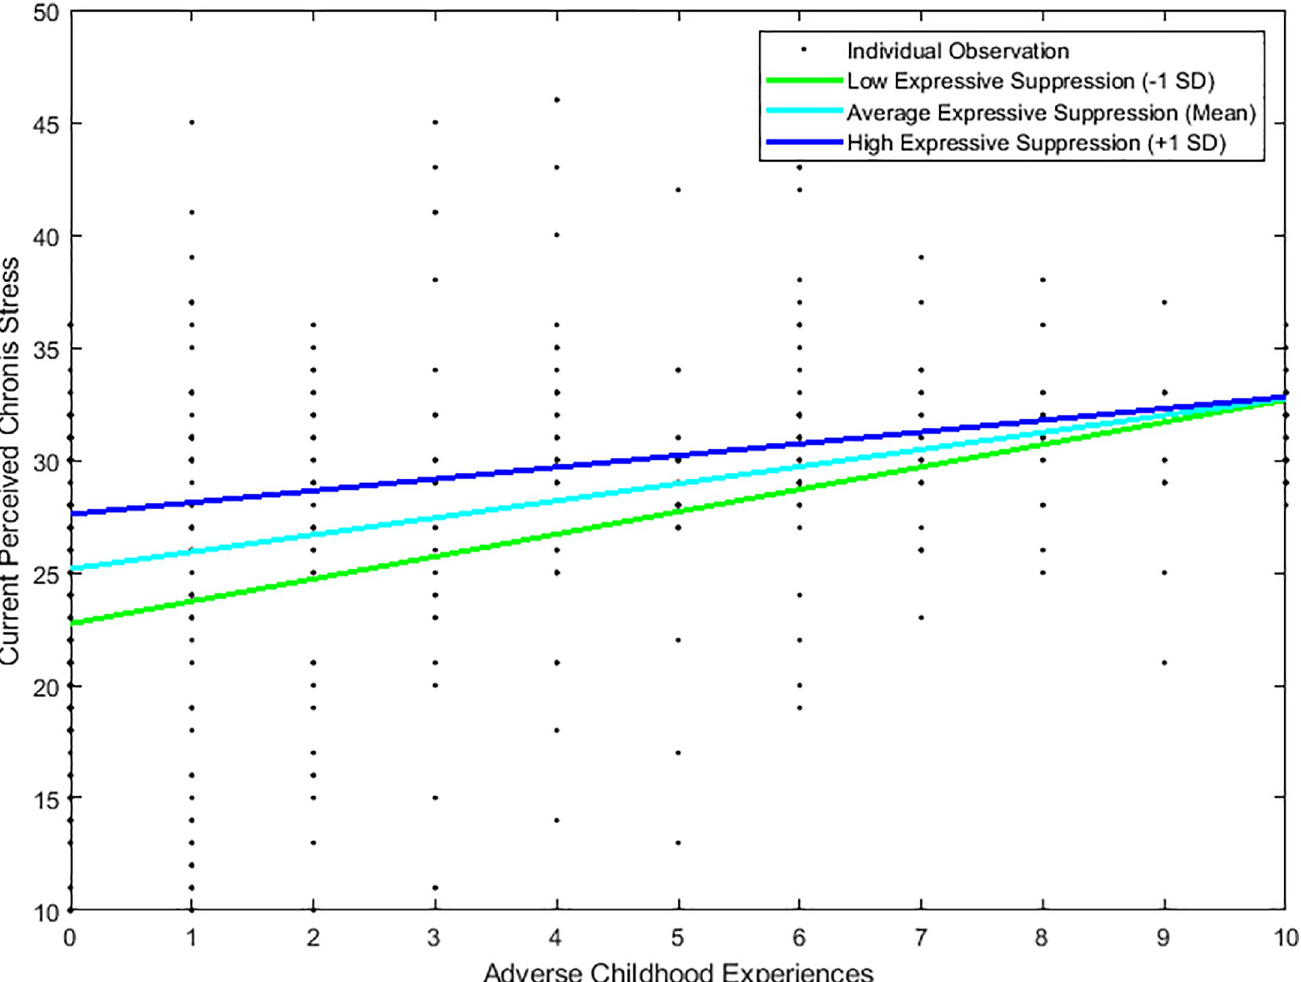
Fig 3. Relation between ACEs and PSS at high, average, and low levels of expressive suppression. https://doi.org/10.1371/journal.pone.0235412.g003 strapping procedures to test the degree to which the indirect effects of the mediation model dif- fer from each other based on different levels of the moderator [62]. The mediating effect of per- ceived stress in the relation between ACEs and CFI-Control is significantly moderated by cognitive reappraisal, as the confidence interval of the index of moderated mediation does not contain zero, b = -0.03, SE = .015, 95% CI: [-.064, -.004]. These results indicate that a greater number of ACEs is associated with higher perceived chronic stress, which is in turn associated with a lessened sense of control in difficult life circumstances. However, the relation between ACEs and perceived chronic stress is buffered by greater habitual use of cognitive reappraisal. CFI control model with expressive suppression as moderator (See Fig 5). The indirect effect of ACEs Scores on CFI-Control through perceived stress scores was significant at low, 95% CI: [-1.13, -0.54], average, 95% CI: [-0.81, -0.46], and high, 95% CI: [-0.64, -0.22] levels of suppression. Additionally, the confidence interval of index of moderated mediation does not contain zero, suggesting the indirect effect of ACEs on CFI through PSS score is significantly moderated by suppression, B = 0.04, SE = 0.02, 95% CI: [.004, .075]. However, the relation